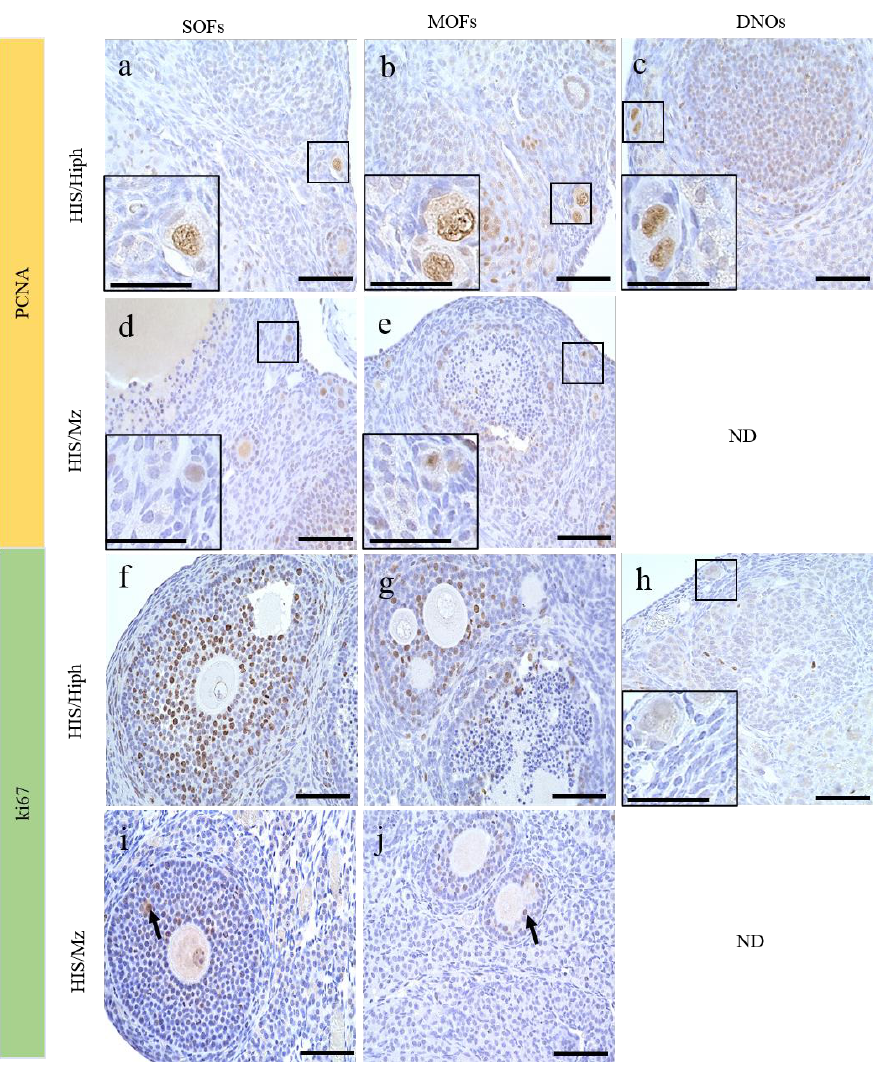
Figure 7. Evaluation of proliferative activity of oocytes in HIS/Hiph and HIS/Mz. ( a – e ) Immunohistochemistry for PCNA. PCNA-positive oocytes in single-oocyte follicles (SOF, a ), multi-oocyte follicles (MOFs, b ), and double-nucleated oocytes (DNOs, c ) are observed in the primordial follicles (PrFs) in HIS/Hiph ( a – c ). PCNA-positive SOFs and MOFs (weak expression) are observed in PrFs in HIS/Mz (d,e). (f – j) Immunohistochemistry for Ki67. Ki67 positivity is are clearly observed in the granulosa cells (GCs) in tertiary follicle-type SOF ( f ) and secondary follicle type-MOFs ( g ) in HIS/Hiph. No positive reactions are observed in oocytes ( f , g ), GCs in primordial follicles, and DNOs ( h ) in HIS/Hiph. A few Ki-67-positive GCs are observed in the SOFs and MOFs (arrows) of HIS/Mz. Scale bars 100 µm or 50 µm (inset). ND: Not detected.